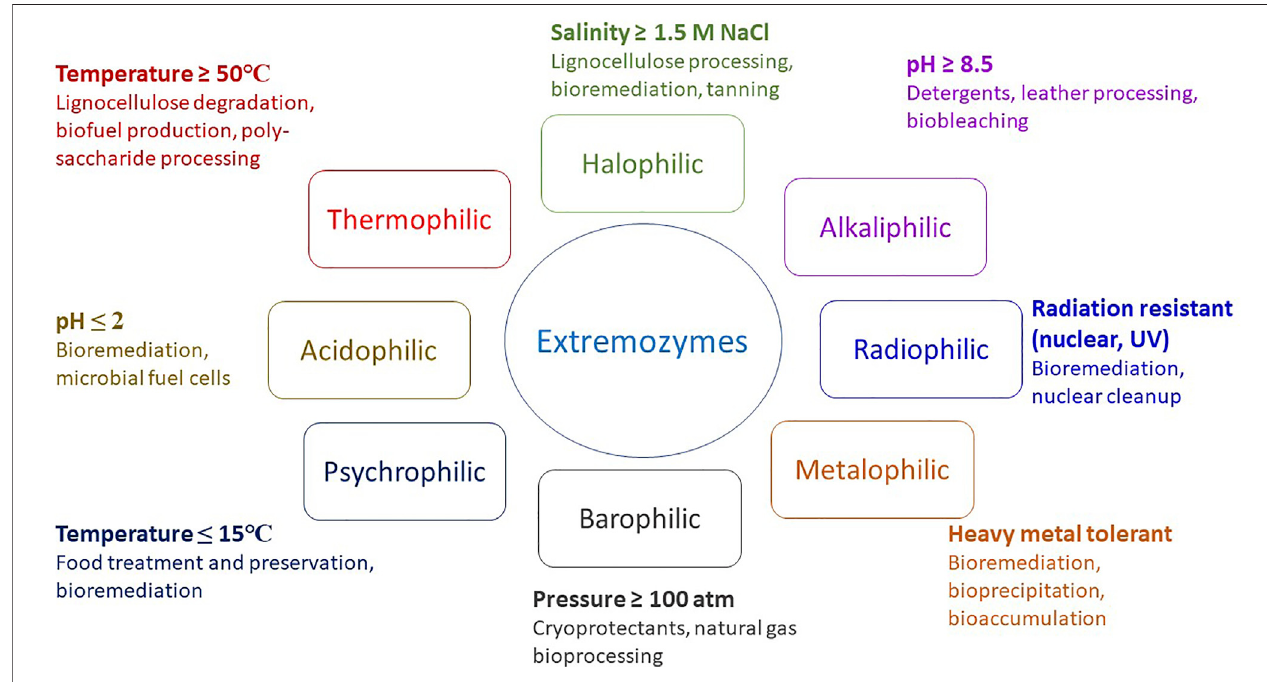
FIGURE 1 | Extremozymes and their potential